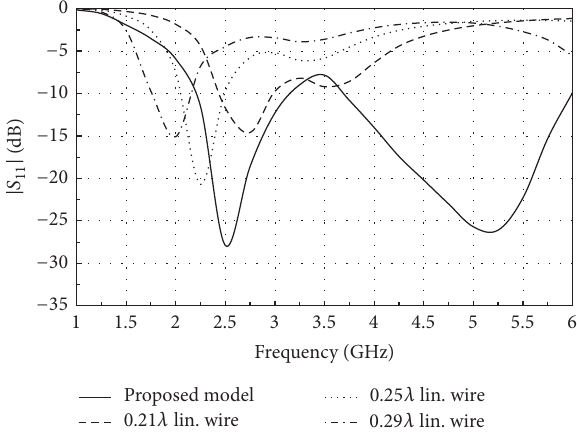
Figure 10: |𝑆 11 | of linear-wire probe versus the proposed